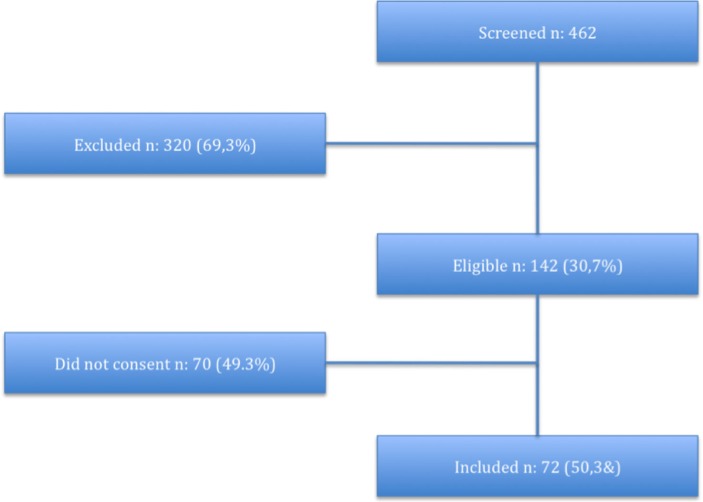
Flowchart of patients that were screened for inclusion in TELEKOL.